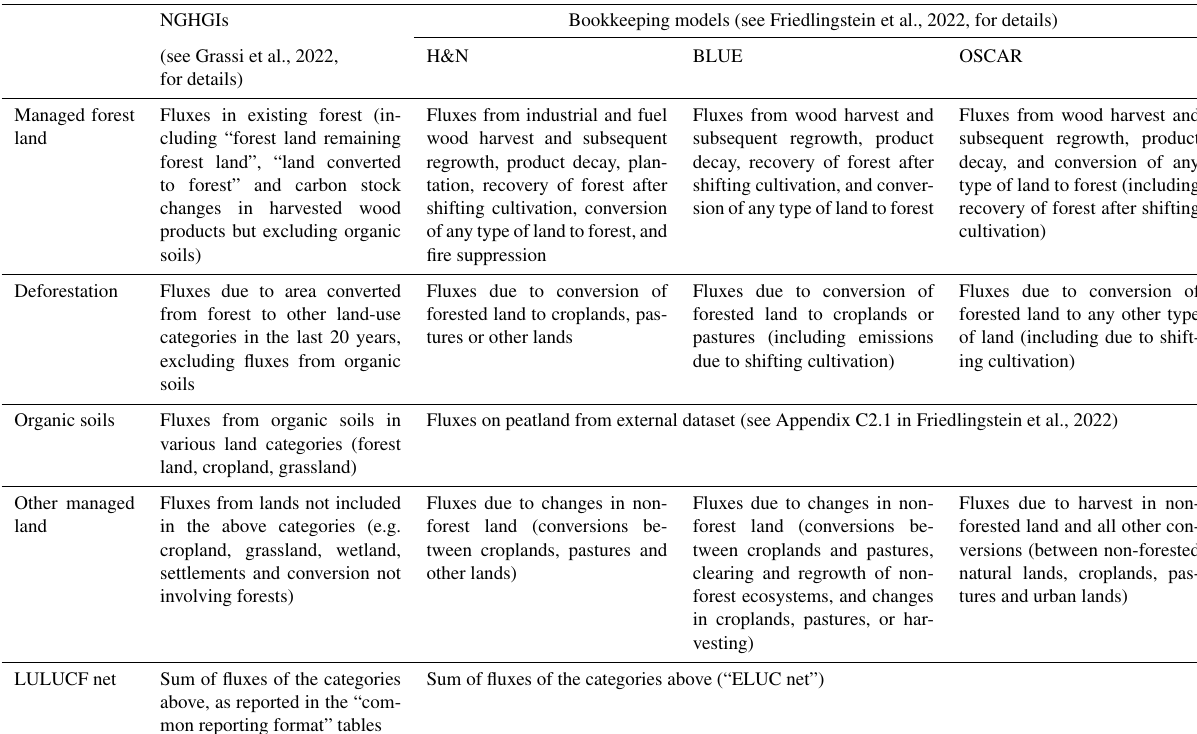
Table 1. Categories of land CO 2 fluxes from NGHGIs and bookkeeping models analysed in this study. NGHGIs Bookkeeping models (see Friedlingstein et al., 2022, for details) (see Grassi et al., 2022, for